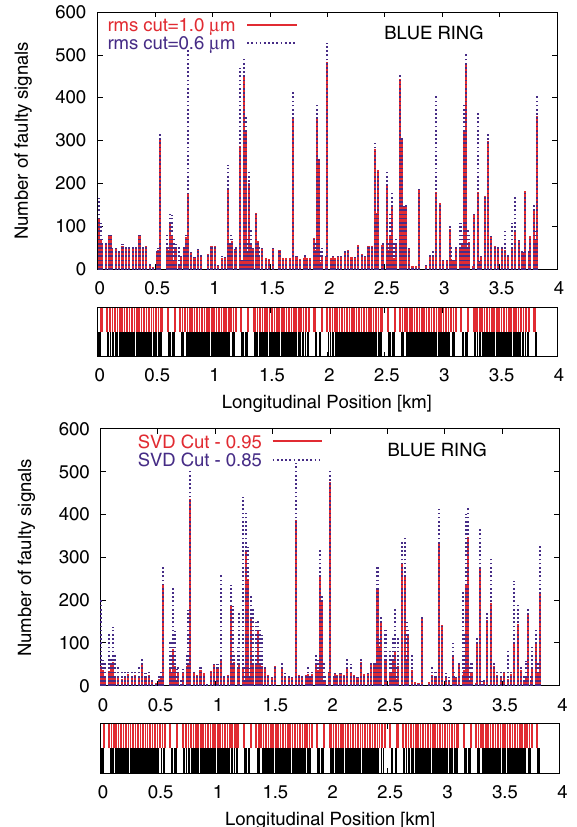
FIG. 15. (Color) Comparison between two different rms and SVD cuts for run